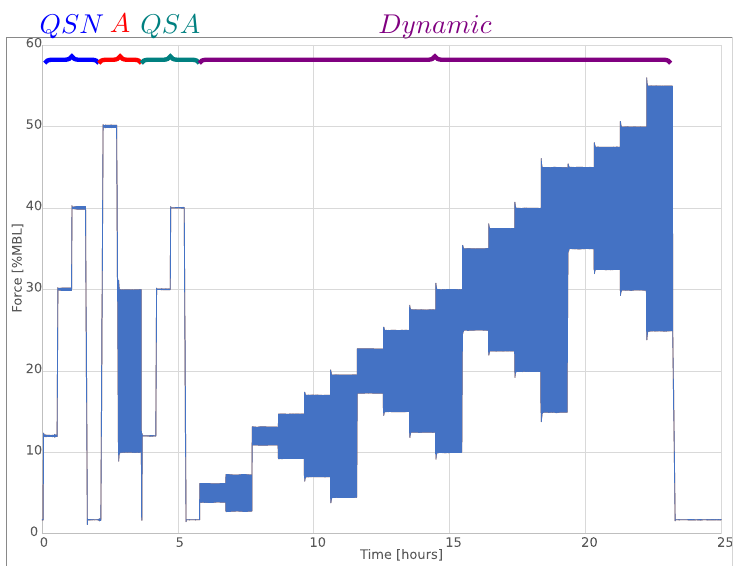
Figure 4. Test procedure for polyester sub-rope. QSN = Quasi-static new stiffness test. A = ageing of rope. QSA = Quasi-static aged stiffness test. Dynamic = Dynamic stiffness